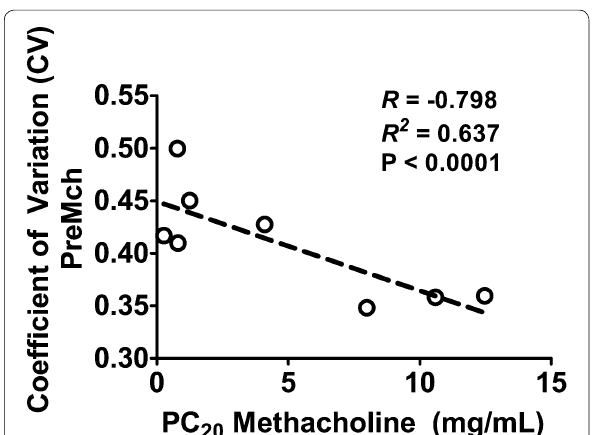
Fig. 5 Relationship between baseline CV and AHR. Here, AHR was measured by the concentration of methacholine that elicits a 20% decrease in the subject’s FEV 1 compared to baseline (PC 20 ) dose. Lower PC